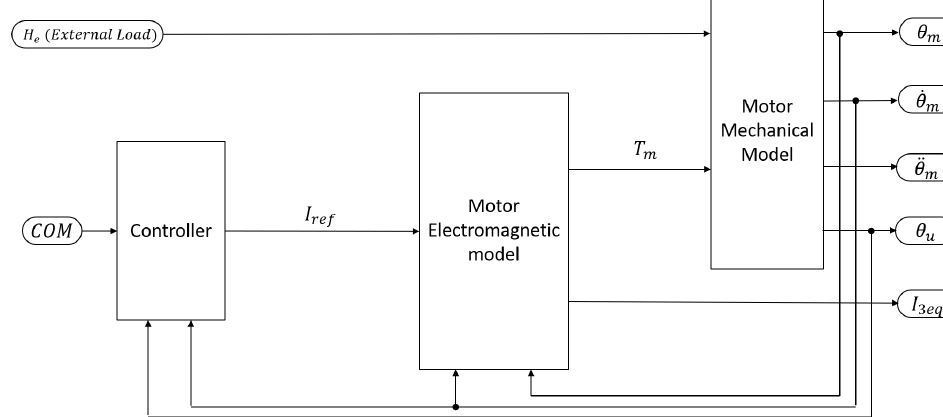
Figure 3. Overview of the top level of the EMA Mdel.